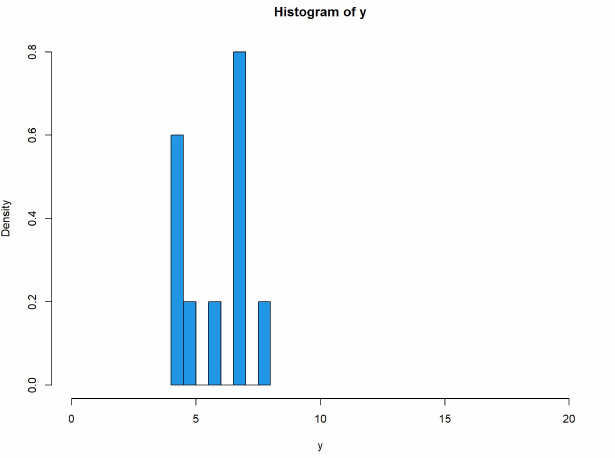
Figure 3. The observed value of theta from the